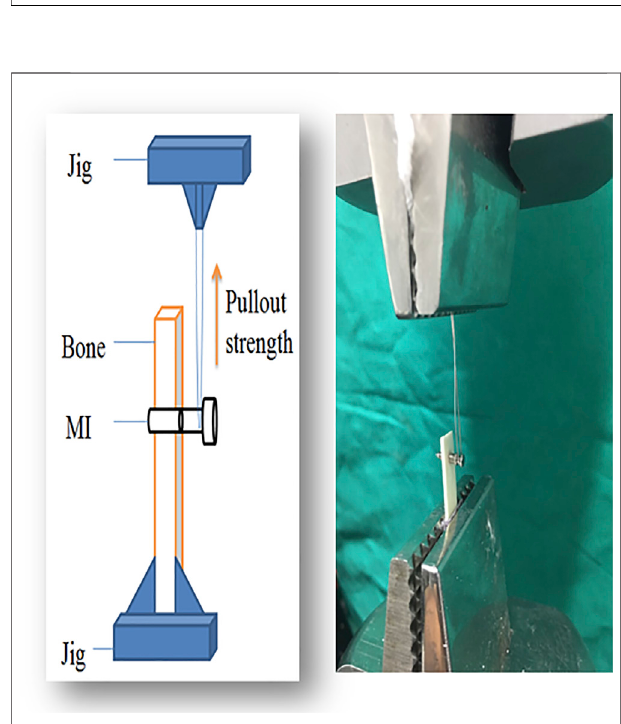
FIGURE 1 | The schematic diagram of ultrafast laser micromachining system.